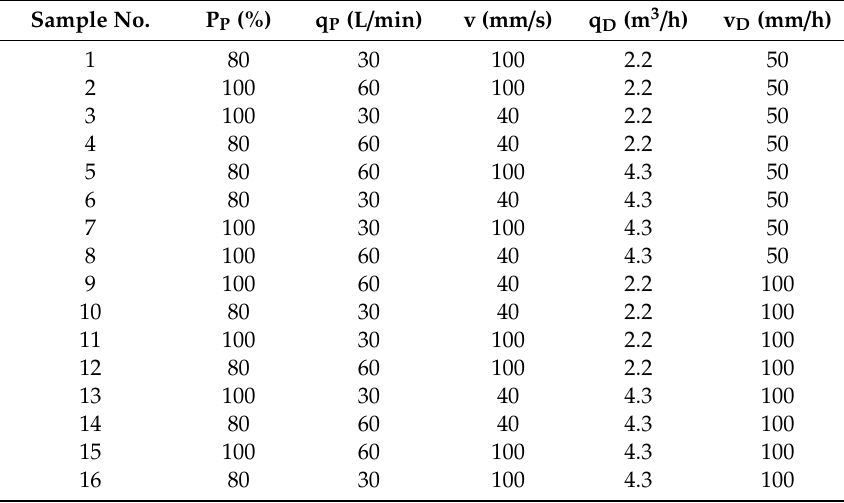
Table 2. Di ff erent coating parameters of the